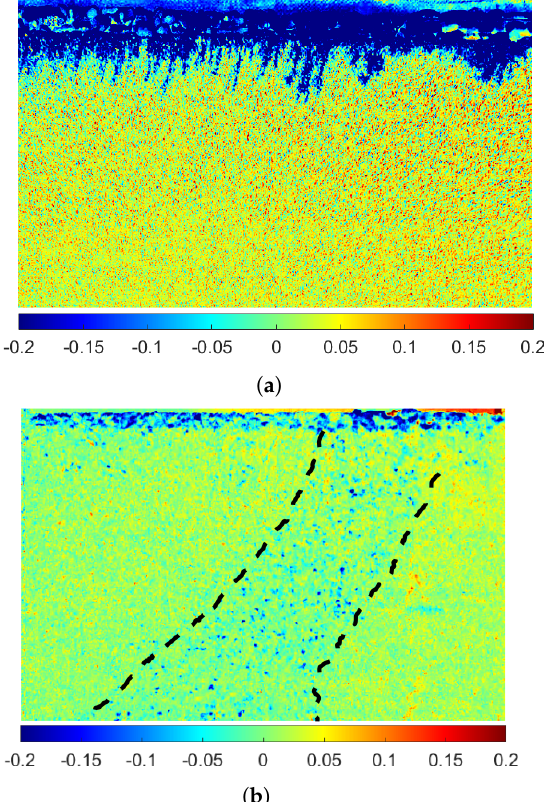
Figure 5. False color of image showing the infiltration patterns of fine material and type of infiltration for two different substrates. ( a ) Fingers pattern and bridging. Substrate sediment is sand D s = 1.9 mm, Q sur = 0.053 l/s and Q sub = 0.006 l/s ; ( b ) Unimpeded static percolation. Substrate sediment is fine gravel D 50 s = 4.5 mm, Q sur = 0.02 l/s and Q sub = 0.04 l/s. The false color is initial state, t = 0 s, minus final